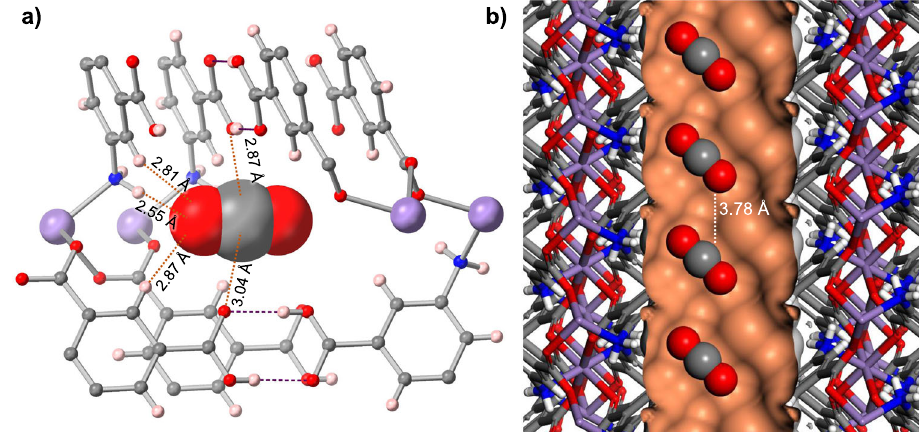
Fig. 3 CO 2 capture by MUF-16. a The adsorption sites of CO 2 molecules in the pores of MUF-16(Mn), as determined by single-crystal X-ray diffraction. The CO 2 is depicted in space- fi lling mode. Key intermolecular distances between MUF-16(Mn) and the adsorbed CO 2 are shown with dashed orange lines. A second, symmetry-equivalent CO 2 adsorption site exists. b Adsorbed CO 2 molecules in MUF-16(Mn) highlighting the arrangement of adsorbed CO 2 in the framework channels and potential attractive noncovalent interactions between adjacent guests. The CO 2 molecules are shown in representative orientations in one of two symmetry-related crystallographic orientations. Colour code: manganese = lilac; nitrogen = blue; oxygen = red; carbon = grey; hydrogen = pale pink or white; pore Connolly surface =